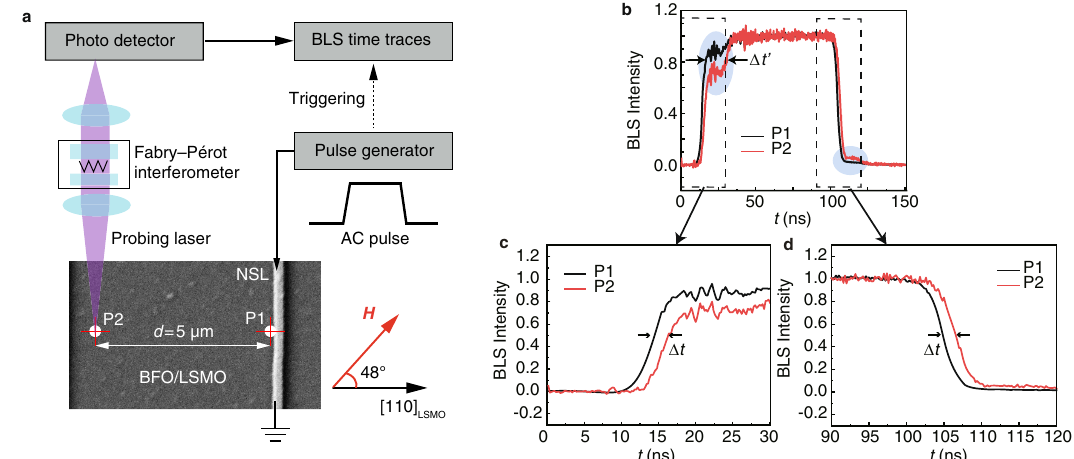
Fig. 4 Time-resolved BLS measurements on the BFO/LSMO heterostructure. a Sketch of the time-resolved BLS setup and the SEM image of the investigated sample. Probing positions P1 and P2 are depicted in the SEM image with a separation distance d ¼ 5 μ m. The measurement is conducted at 100mT with the external fi eld applied 48° to the [110] crystal direction of LSMO. b A microwave pulse with the frequency of 7.5GHz is injected into the NSL antenna. Rising and falling edges are observed at P1 (black line) and P2 (red line) by time-resolved BLS. The blue ellipses mark the slow magnon mode with a time delay Δ t 0 . c A rising in BLS intensity is fi rst observed in P1 which is close to the NSL antenna, and the rising edge arrives at P2 with a time delay Δ t . d After the microwave pulse, the falling of the BLS intensity is fi rst observed in P1 and then arrives at P2 with the time delay Δ t